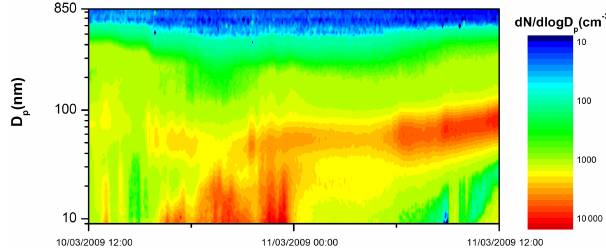
Figure 3. Example of appearance of nucleation mode particles dur- ing several hours as observed during the night of 10 to 11 March 2009 (time in UTC+2).